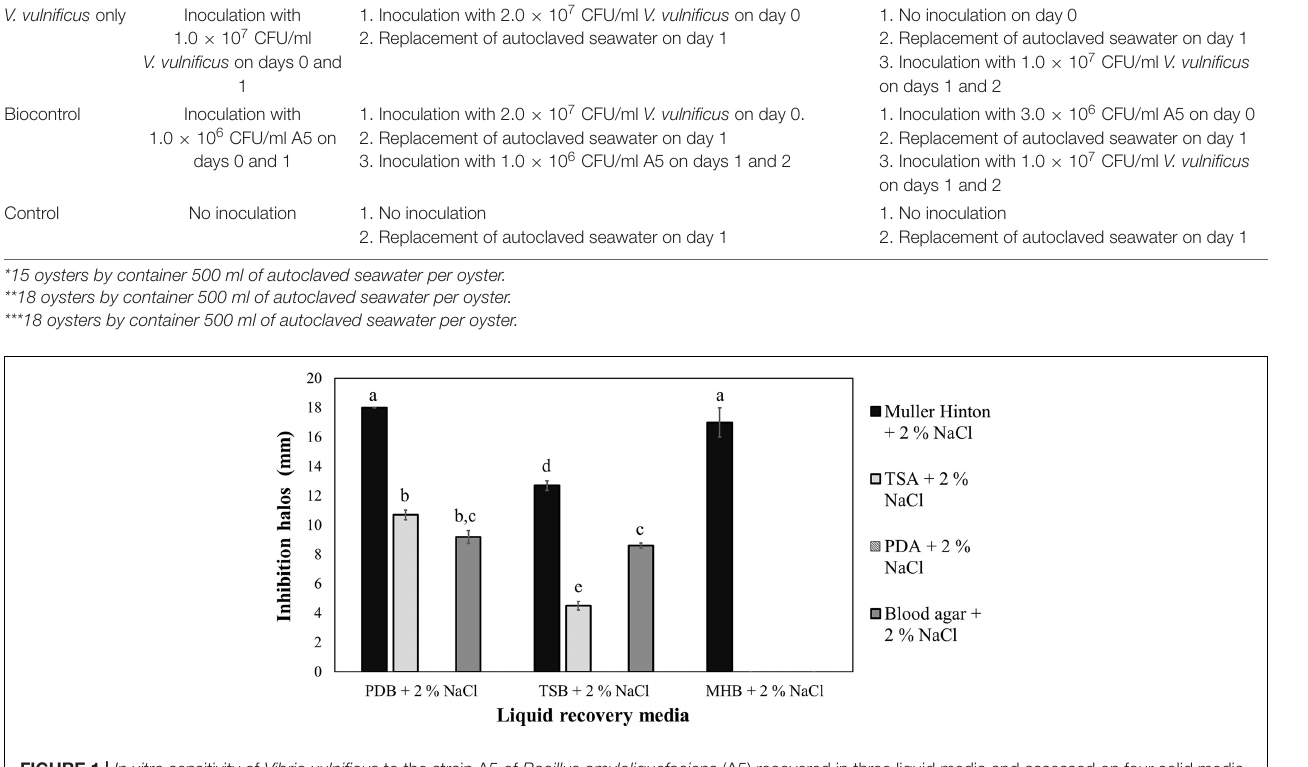
the virulence-correlated gene (vcg) was amplified with the primers P2 (5 (cid:48) -CTCAATTGACAATGATCT-3 (cid:48) ) and P3 (5 (cid:48) - CGCTTAGGATGATCGGTG-3 (cid:48) ) (Rosche et al., 2005). The amplicons obtained were sequenced in a service lab (Macrogen, Seoul, South Korea), and the data were analyzed using the Basic Local Alignment Search Tool (BLAST) algorithm from